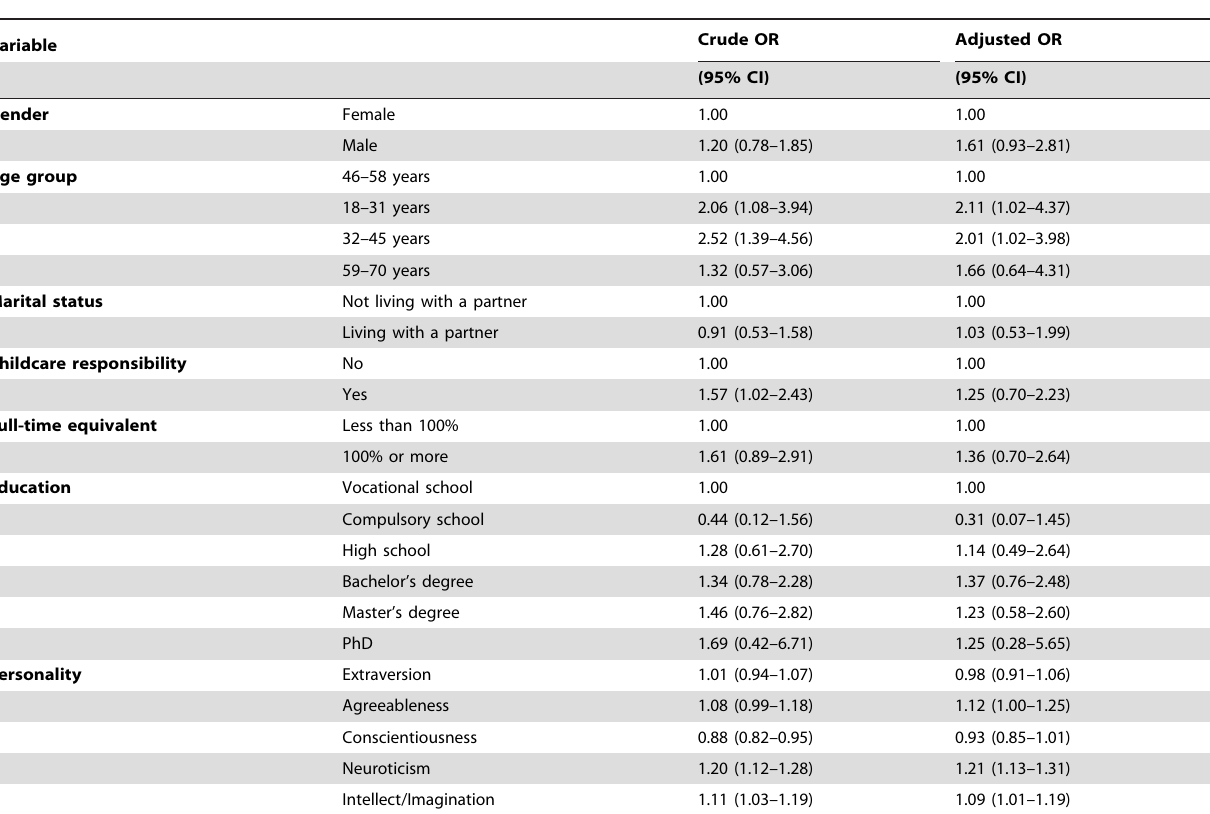
Table 6. Logistic regression analysis, where workaholism (0 = not workaholic, 1= workaholic) comprised the dependent variable and where gender, age, marital status, caretaker responsibility for children, percentage of full-time equivalent, education and personality comprised the independent variables (N